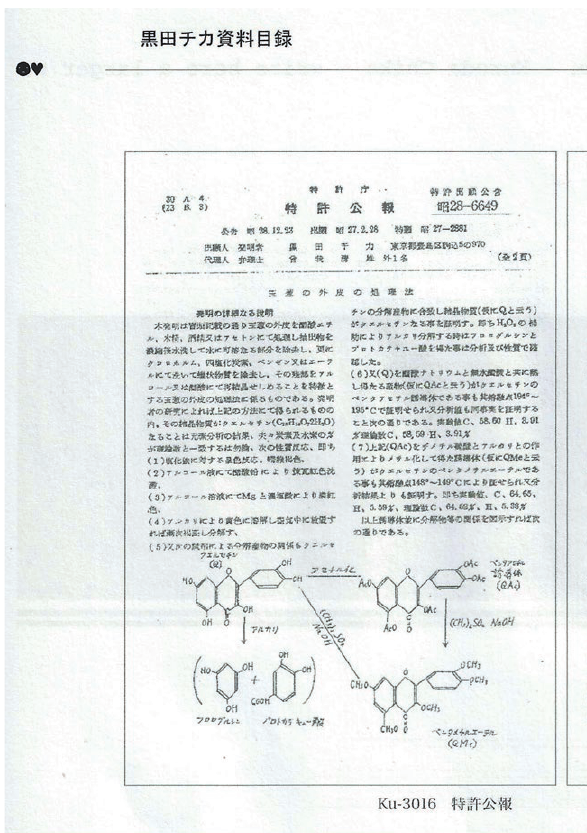
Figure 15. (Ku-3016) Kuroda patent 1953 玉葱 【たまねぎ】の外皮 の焼瑾法 “the way to bake an onion [and make it] like a beautiful